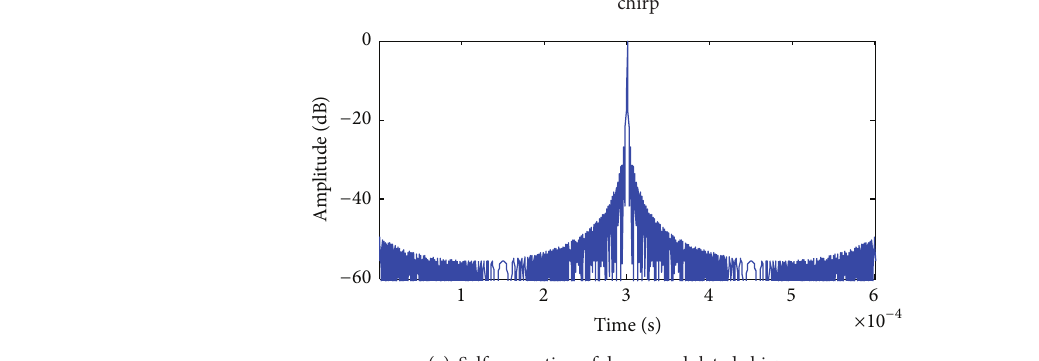
(b) Cross-correlation between up modulated chirp and down modulated chirp